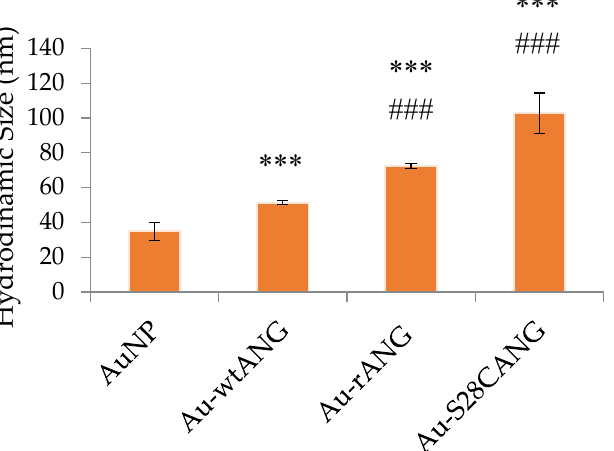
Figure 3. Hydrodynamic size of the bare AuNP (4.3 × 10 8 NP /mL) and the functionalized nanosystems Au-wtANG (2.9 × 10 7 NP /mL), Au-rANG (1.4 × 10 7 NP /mL), Au-S28CANG (7.3 × 10 6 NP /mL), measured by DLS. (***) = p < 0.001 vs. AuNP; (###) = p < 0.001 vs. Au-wtANG (one-way ANOVA).